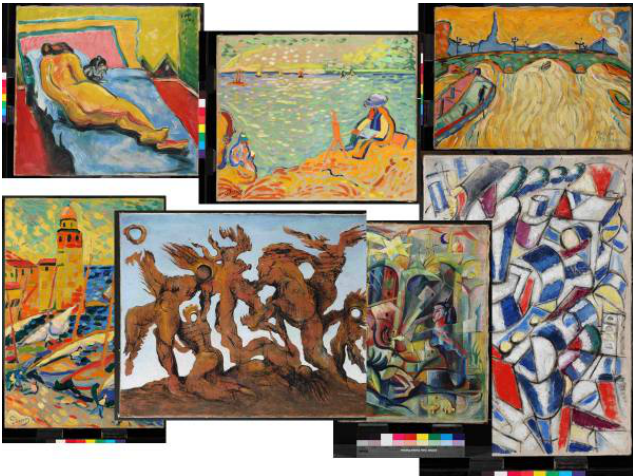
Figure 1. Overview over the seven paintings of the Beltracchi case, with their attributions from upper